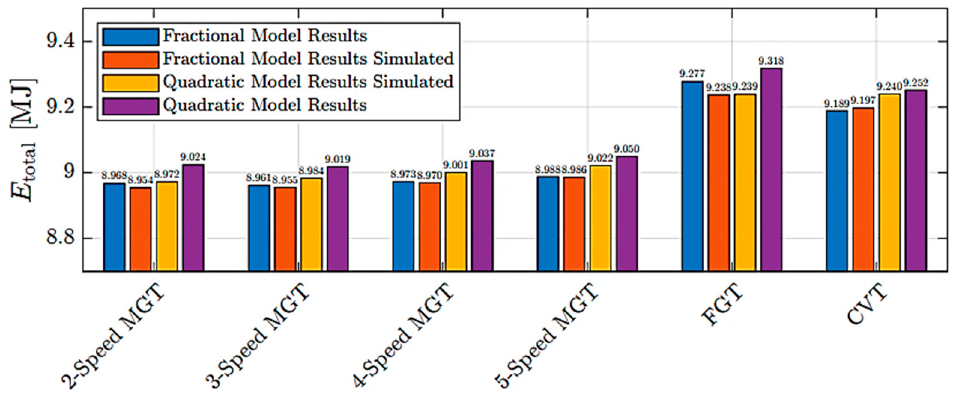
Figure 32. Power consumption for FGT, MGT, and CVT transmissions for fractional and quadratic models and their respective simulations.